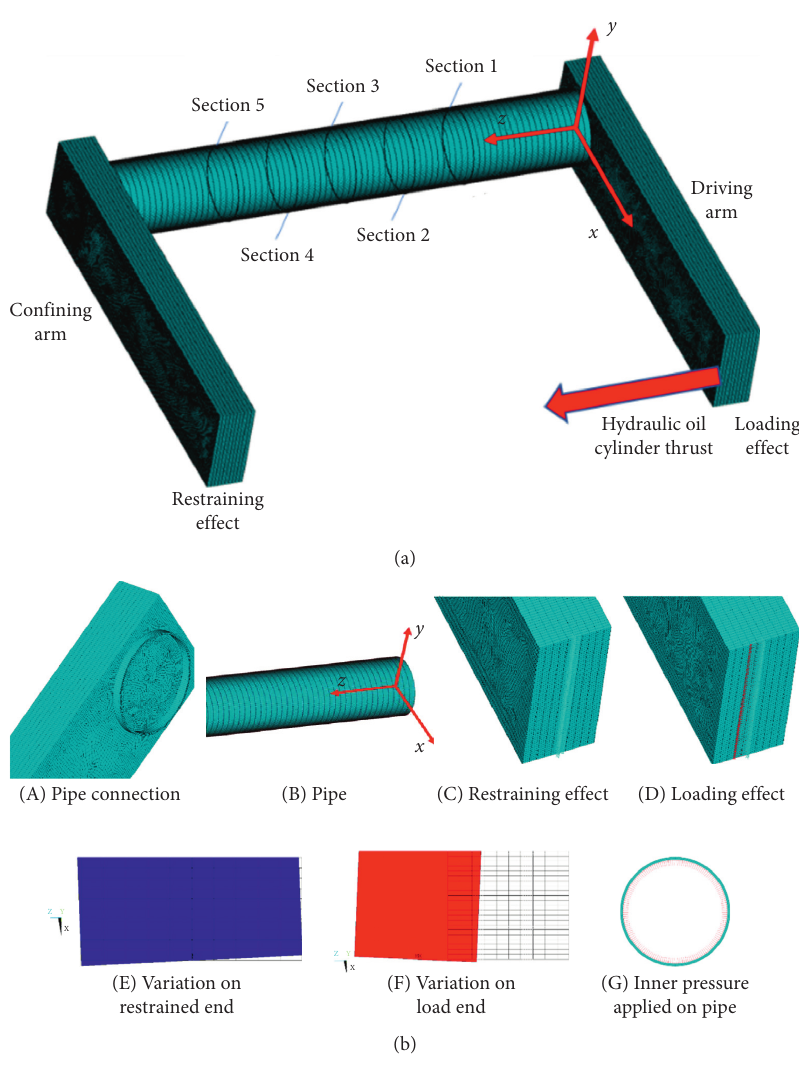
Figure 6: Finite element model established based on mechanical loading experiment: (a) overall model; (b) partial